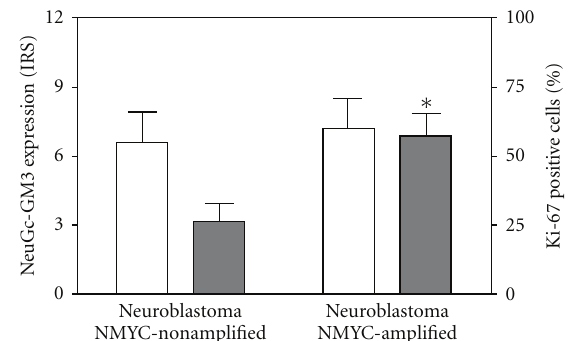
Figure 2: Expression of NeuGc-GM3 ganglioside and Ki-67 protein in NMYC-amplified and -nonamplified neuroblastoma. NeuGc- GM3 (open bars) was assessed with the immunoreactive score (IRS) and the percent of Ki-67 positive cells (closed bars) was used as a proliferation index. Data represent mean ± SEM. ∗ P < 0 . 02 ( t